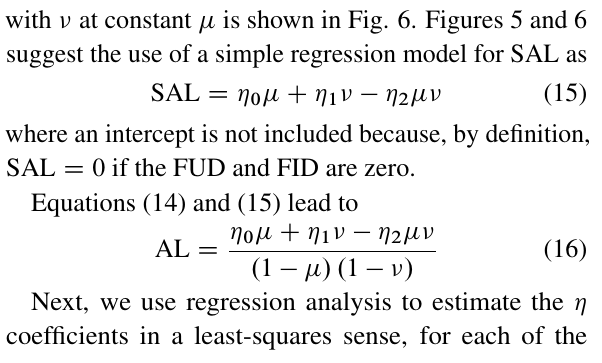
Fig. 5 SAL versus FUD using P 1 at constant FID